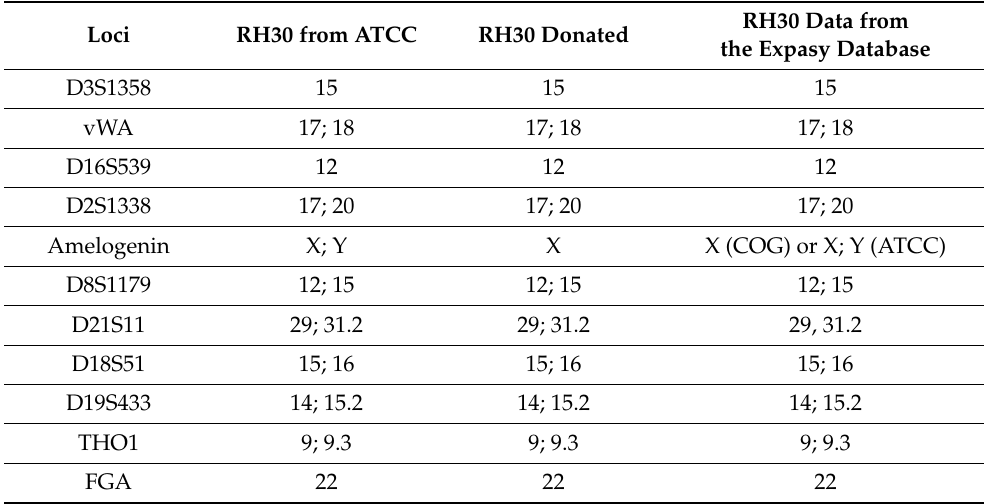
Table 1. STR profile of RH30 cells from two different sources: bought from ATCC or donated; in comparison to literature data from the Expasy